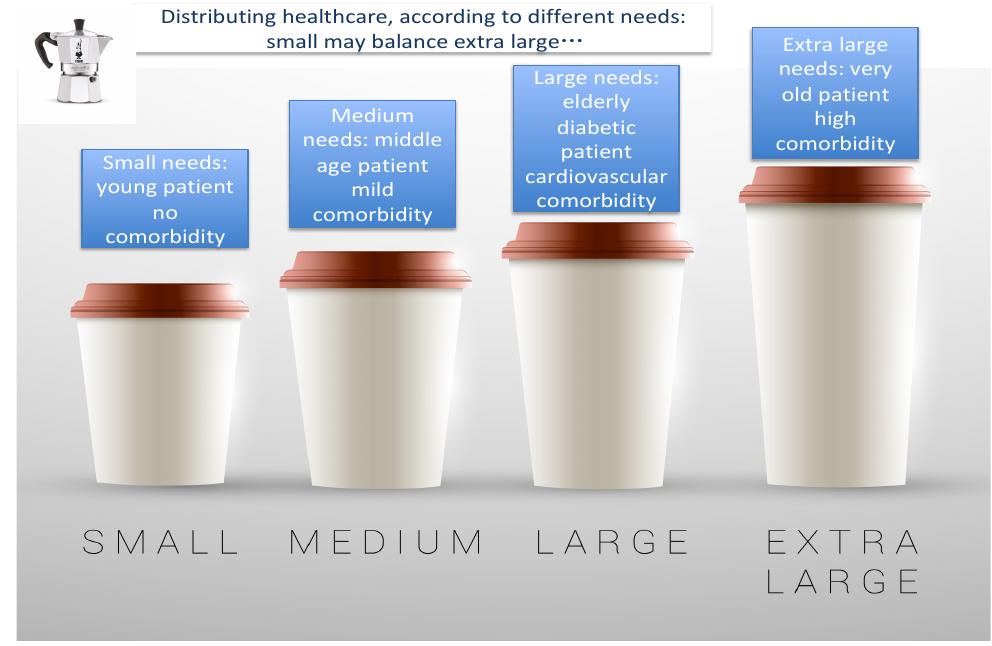
Figure 2. A distributive approach to dialysis reimbursement.